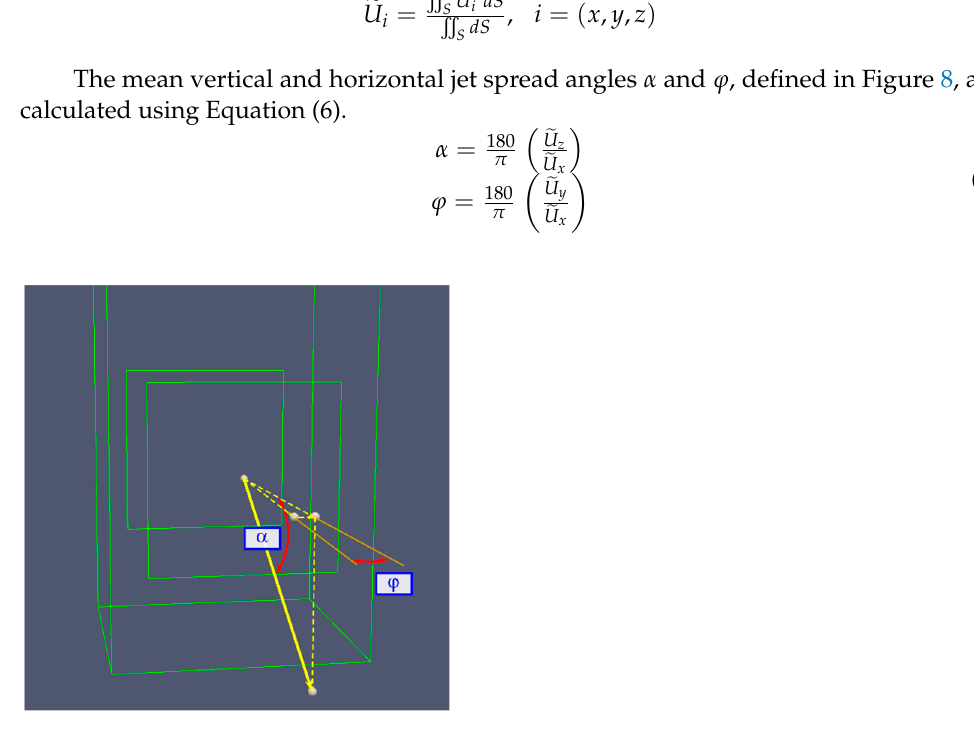
Figure 8. The angles used to characterize the outflow spread in vertical ( α ) and horizontal ( ϕ ) directions. These are measured with respect to the port normal vector which is parallel to the x axis.